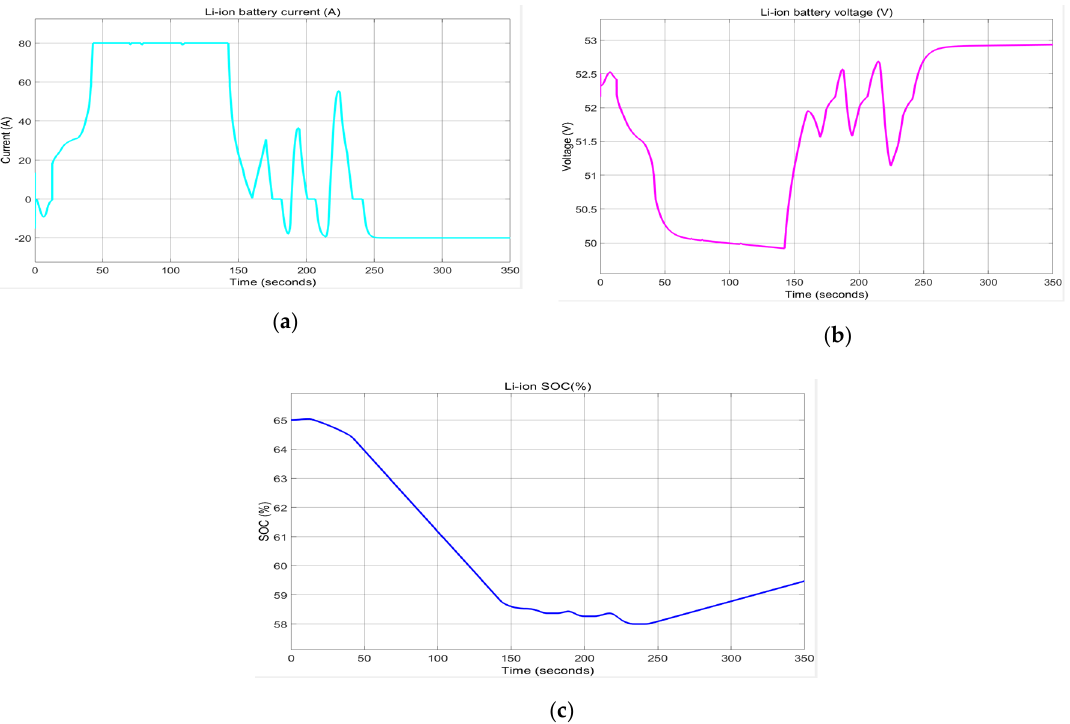
Figure A3. Fuel cell (FC). ( a ) FC current; ( b ) FC voltage; ( c ) FC consumption.